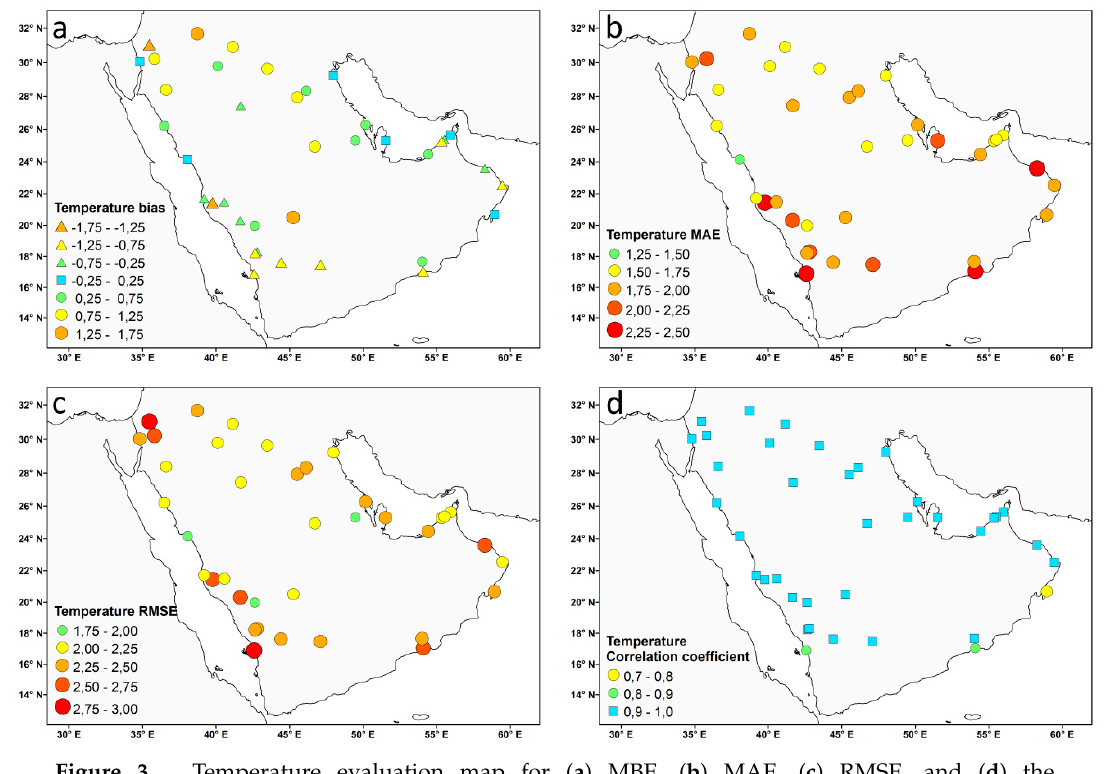
Figure 3. Temperature evaluation map for ( a ) MBE, ( b ) MAE, ( c ) RMSE, and ( d ) the Correlation Coefficient.